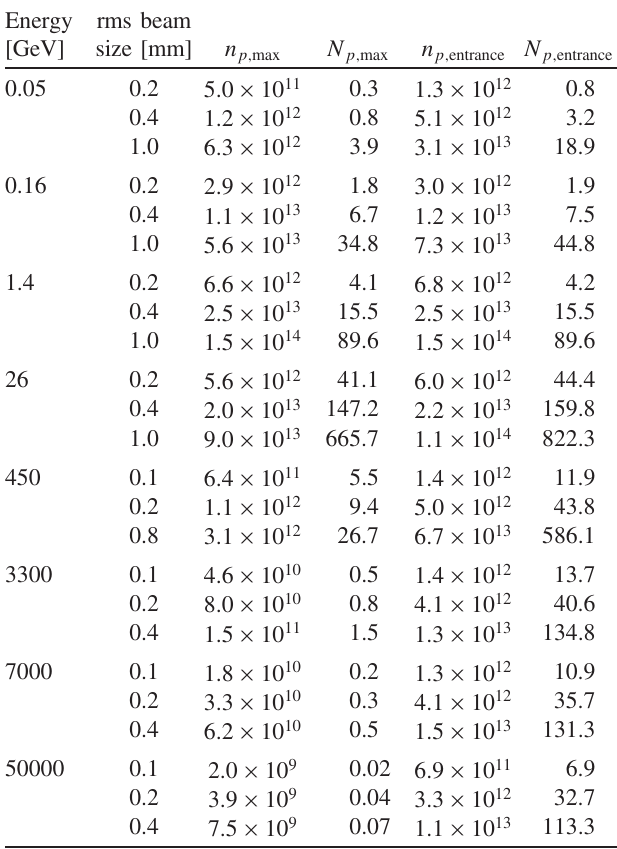
TABLE V. Number of protons and proton bunches needed to melt copper at the maximum energy deposition point as well as at the target front